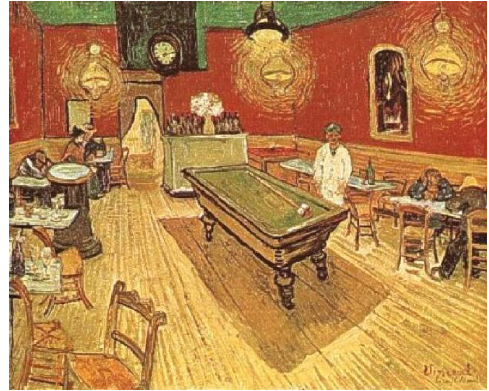
Fig. 19 View of St. Peter’s square (Piranesi, 1748)